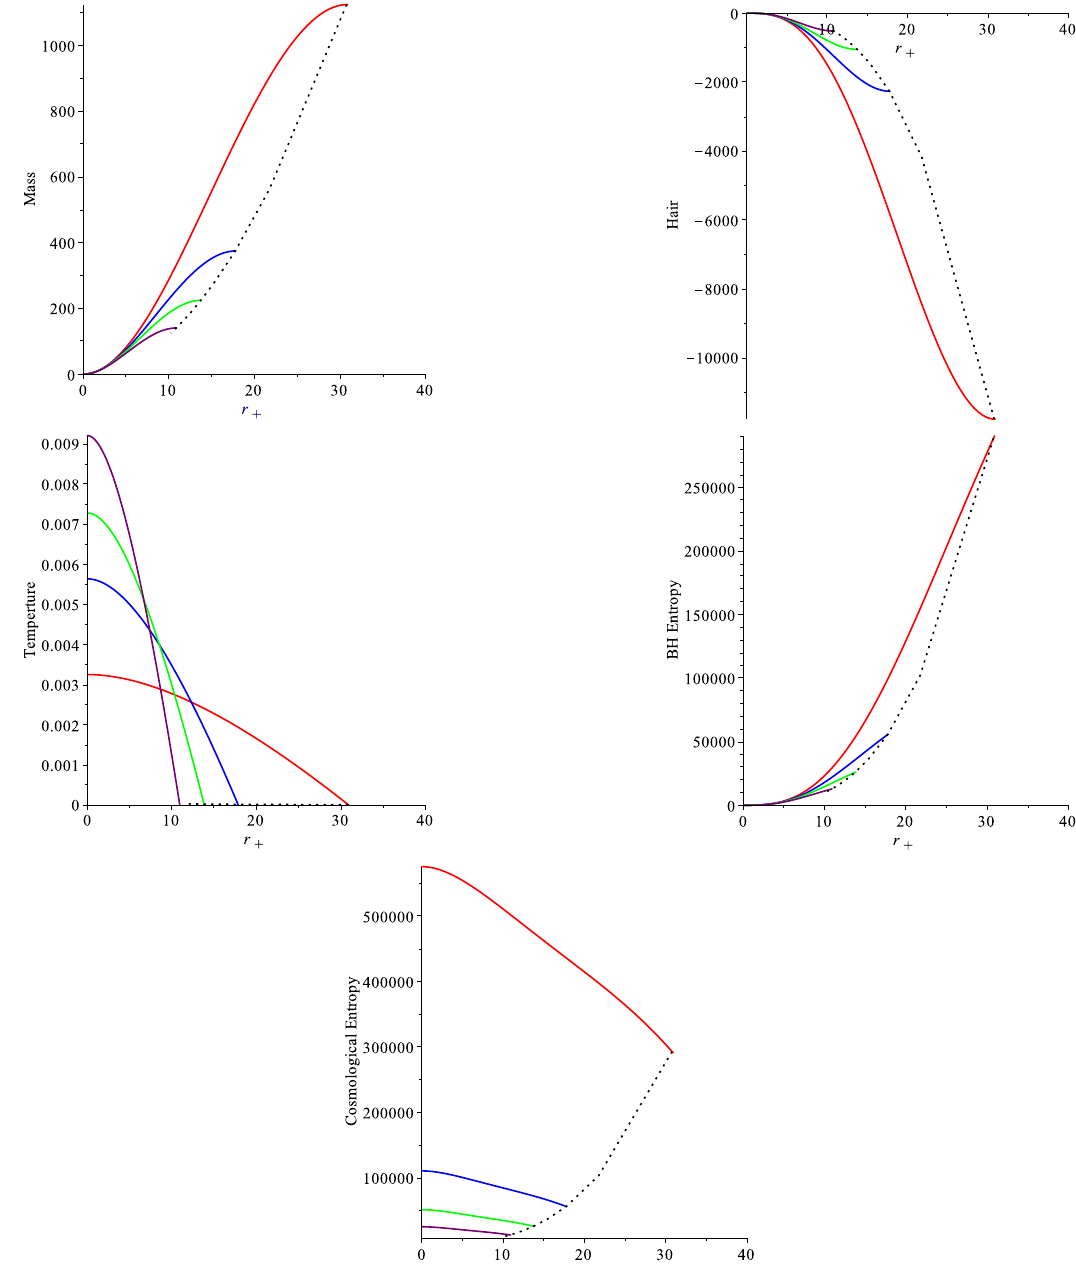
Figure 2 . The thermodynamic parameters of the charged hairy asymptotically de Sitter black holes for (cid:12)xed potential (cid:8) = (cid:0) 0 : 0001. The f red; blue; green; purple g curves correspond respectively to the pressure P = f(cid:0) 0 : 0001 ; (cid:0) 0 : 0003 ; (cid:0) 0 : 0005 ; (cid:0) 0 : 0008 g . The dotted line represents the Nariai limit.